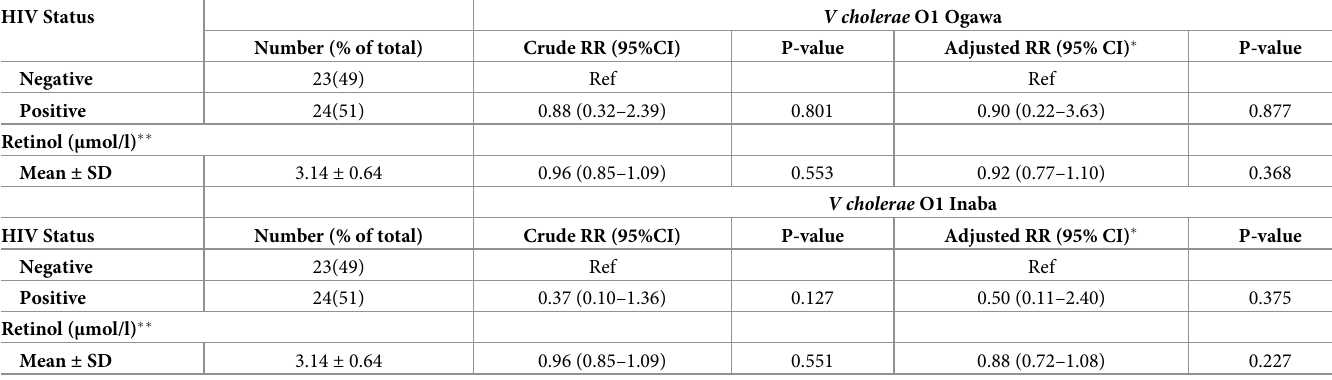
Table 3. Percent seroconversion by HIV status and retinol